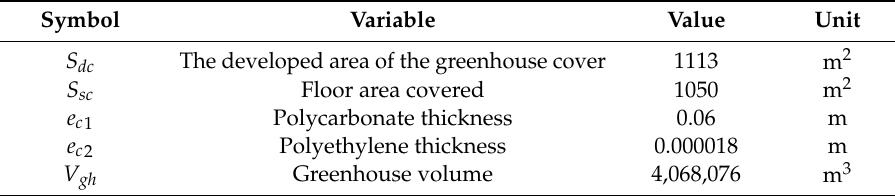
Table 2. Characteristics of the greenhouse and its components.